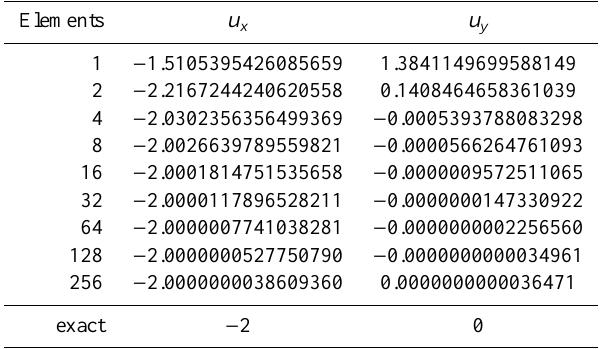
Table 2. Displacement of the tip in case of large bending and tor- sion in Sect. 6.3 compared to a numerical solution with 40 beam elements in the software package ANSYS.